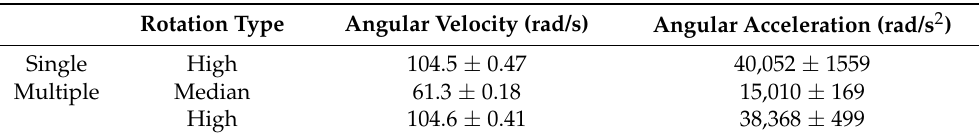
Table 1. Summary of Angular velocity and accelerations of single and multiple RNR injuries. Values represent the calculated average ± standard